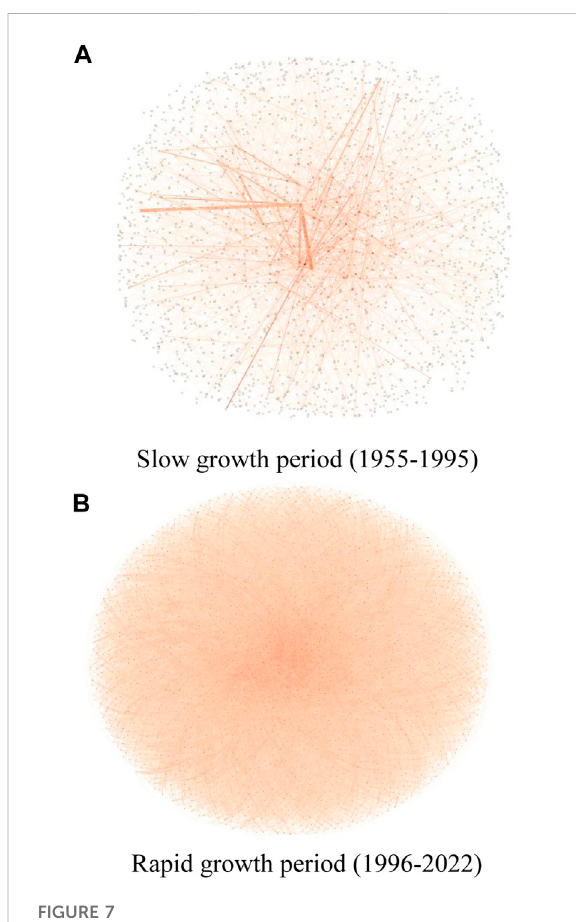
FIGURE 7 Patent roadmap of the main patent owner in the fi eld of electrode technology for